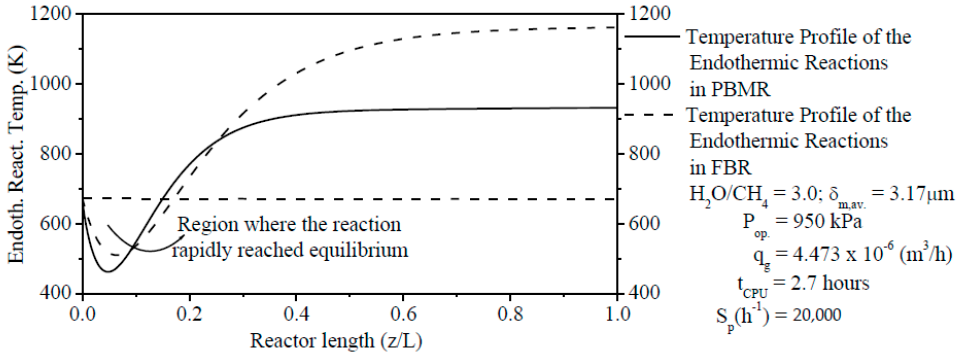
Figure 3. Comparison of the Temperature Profiles of Endothermic Reactions (TPERs) along the length of FBR and along the reaction zone length from PBMR on Ni/ γ -Al 2 O 3